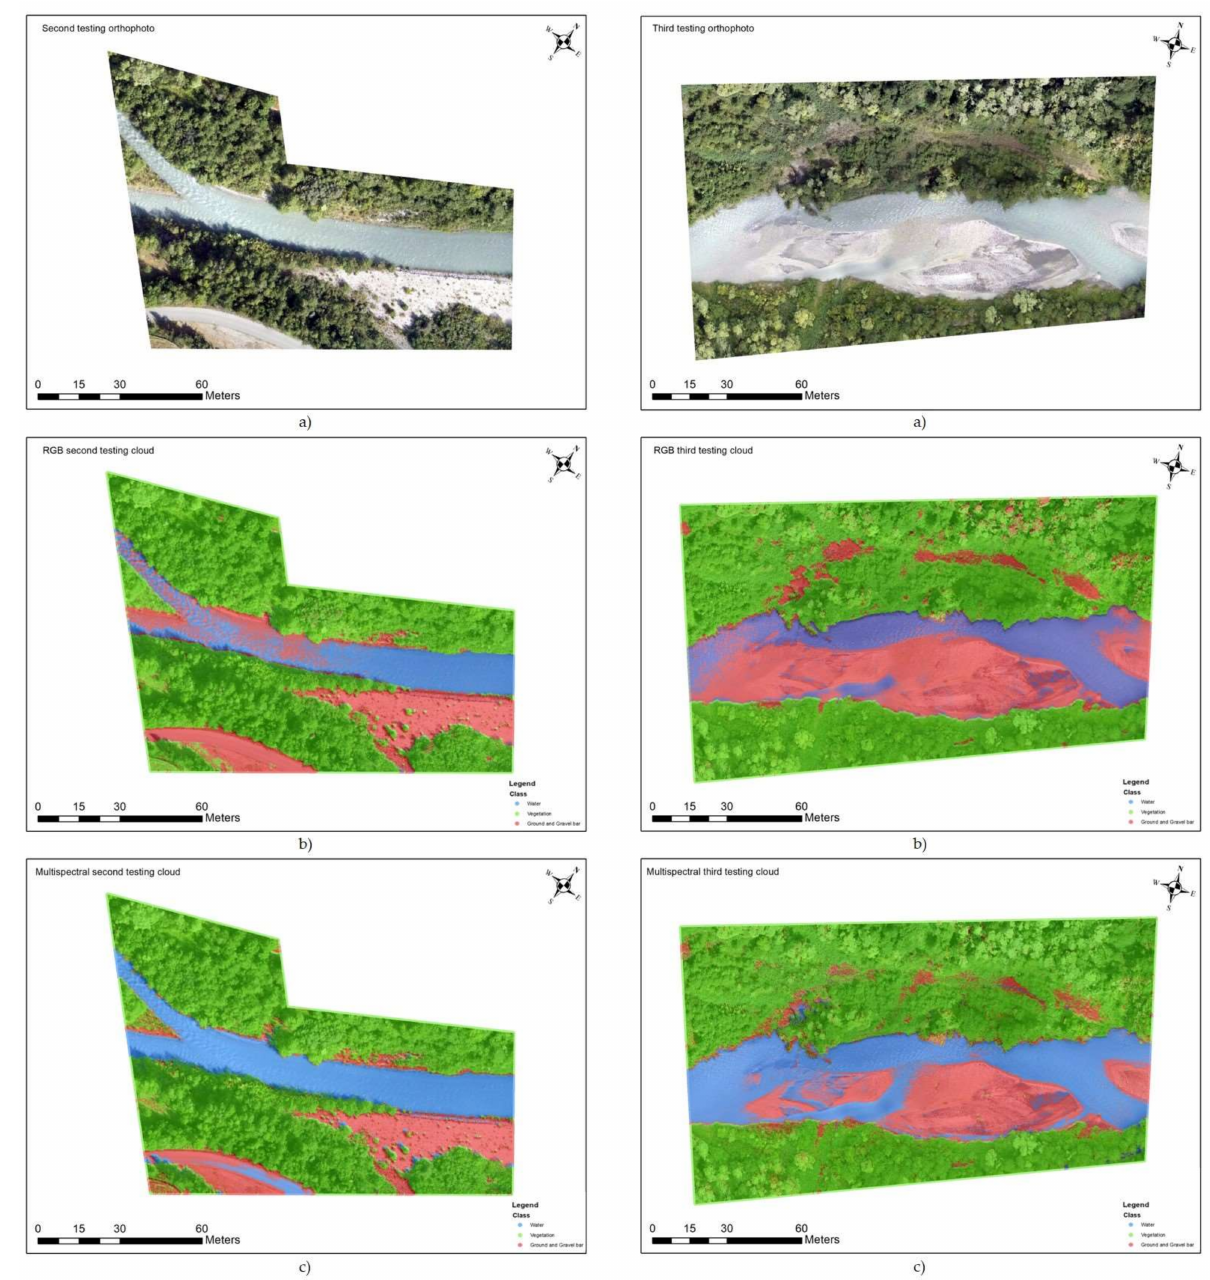
Figure 7. Overall overview obtained in ML automatic classification: ( a ) represents the 8-bit SfM generated orthophotos of second and third testing dataset; ( b ) RGB classified datasets of second and third clouds, where shown are the incorrect and the noisy water classifications; ( c ) shows the RE+NIR classified clouds with the better results obtained in water, vegetation, and ground/gravel bars classes. The classes reported are water (blue), vegetation (green), and ground/gravel bars